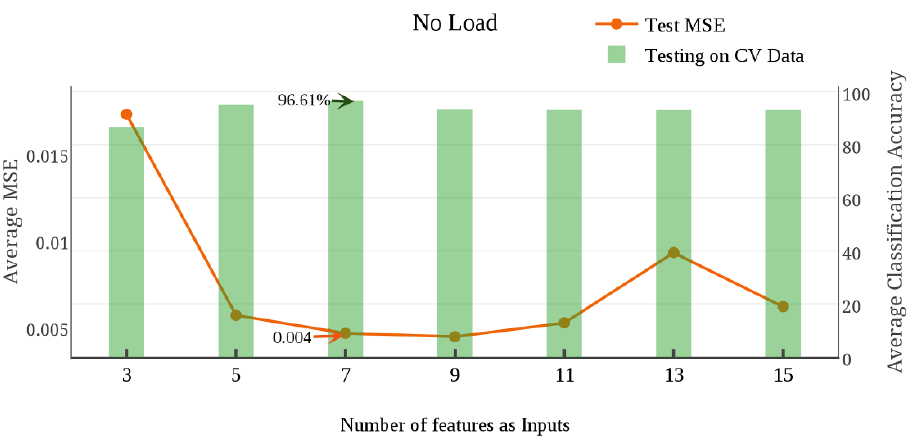
Figure 12. Variation of average classification and MSE with a number of features as inputs in no Load.